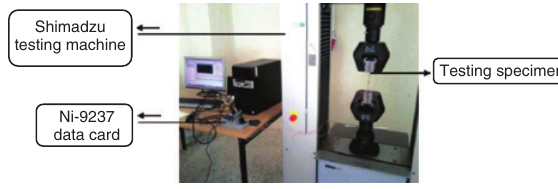
Figure 2: Tensile test